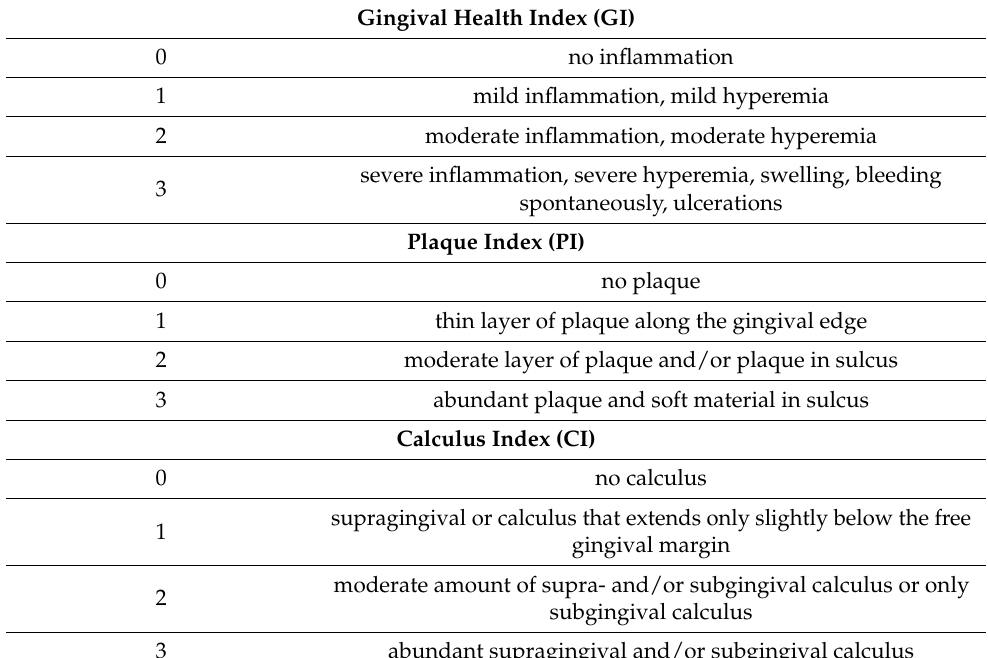
Table 3. Oral health assessment protocol: gingival health index (GI), plaque index (PI), and calculus index